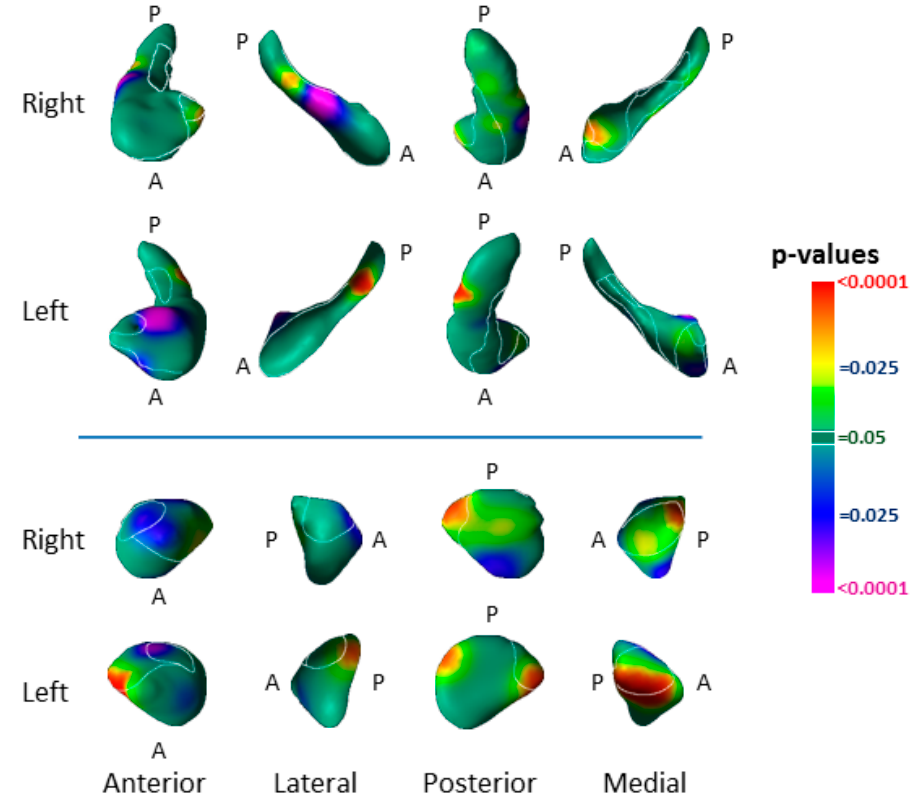
Figure 7. Associations with Current Symptom Severity. Shown here are the associations of symptom severity with surface morphology of the hippocampus and amygdala in both groups combined (HR N = 78, LR N = 67). We defined current symptom severity as the sum of z-scores for depression and anxiety measures in each participant. Independent variables included z-score for symptom severity, age, age 2 , sex, and risk group. Greater symptom severity accompanied inward deformation of the head and body and protrusion of the tail and the hippocampus, as well as inward deformation of the anterior surface of the left amygdala and protrusion the medial surface of both amygdalae.